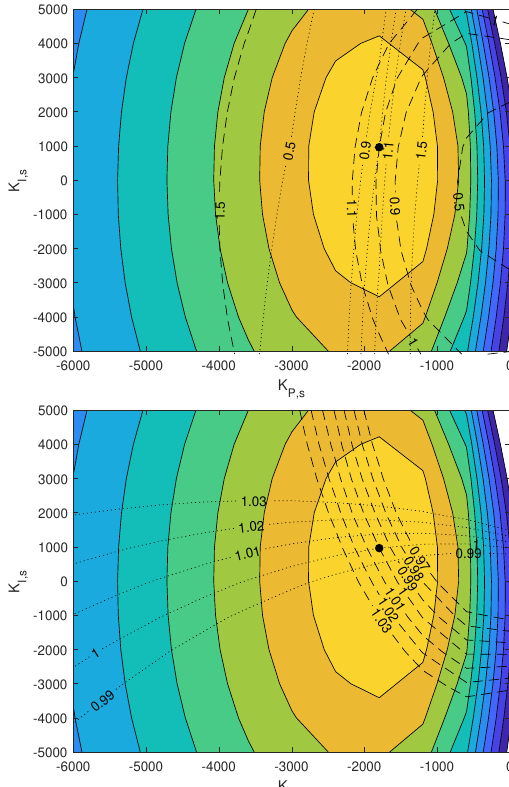
Fig. 9: Power contour of the coupled surge/pitch de- gree of freedom for Wave ID 10A. The contour slice is taken at the pitch gain that maximizes surge-pitch power capture, so that the presented axes show varia- tion with surge gains. The hashed lines mark the PTO load contours and dotted lines are the fatigue damage contour for the surge DOF (top) and the pitch DOF (bottom).